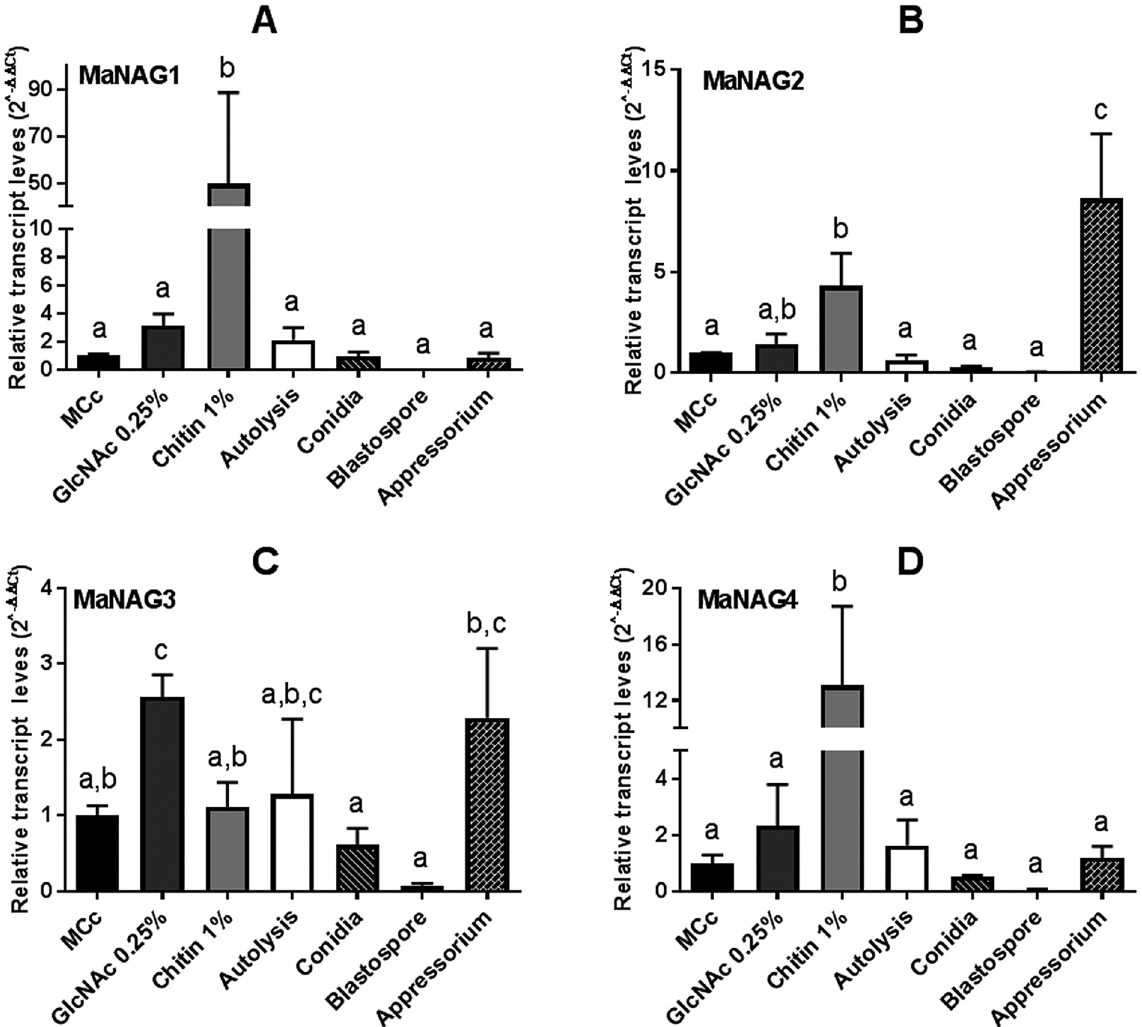
Figure 4 - Relative expression of GH20 and GH3 NAGase genes in M. anisopliae , considering MCc as the reference condition. Transcriptional profiles of GH20 NAGase genes (MaNAG1 and MaNAG2) and GH3 NAGase genes (MaNAG3 and MaNAG4) in seven different conditions (mycelium growth ondifferentcarbonsourcemedia,autolysis,anddifferentcelltypes),using tef1 (cid:4) asareferencegeneandapplyingthe2 - (cid:5)(cid:5) Ct method.A) nag1 ;B) nag2 ;C) nag3 ; D) nag4 . Standard error bars are indicated. Different letters indicate statistically significant differences ( p < 0.05) among studied